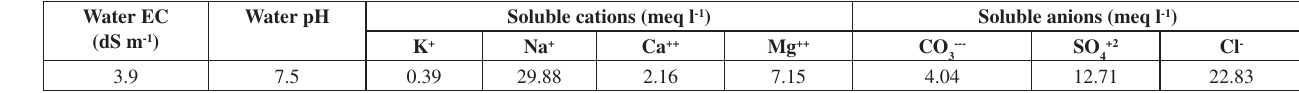
Table 3: Chemical analysis of irrigation